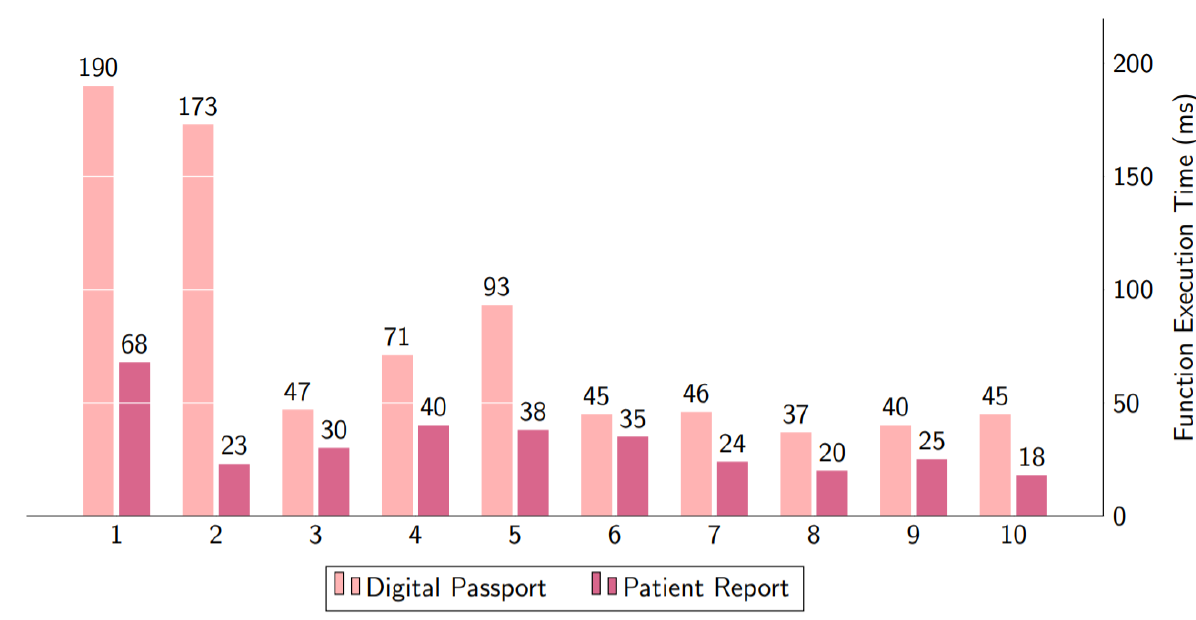
Figure 12. The computational time for data storage in IPFS and Blockchain via function execution.